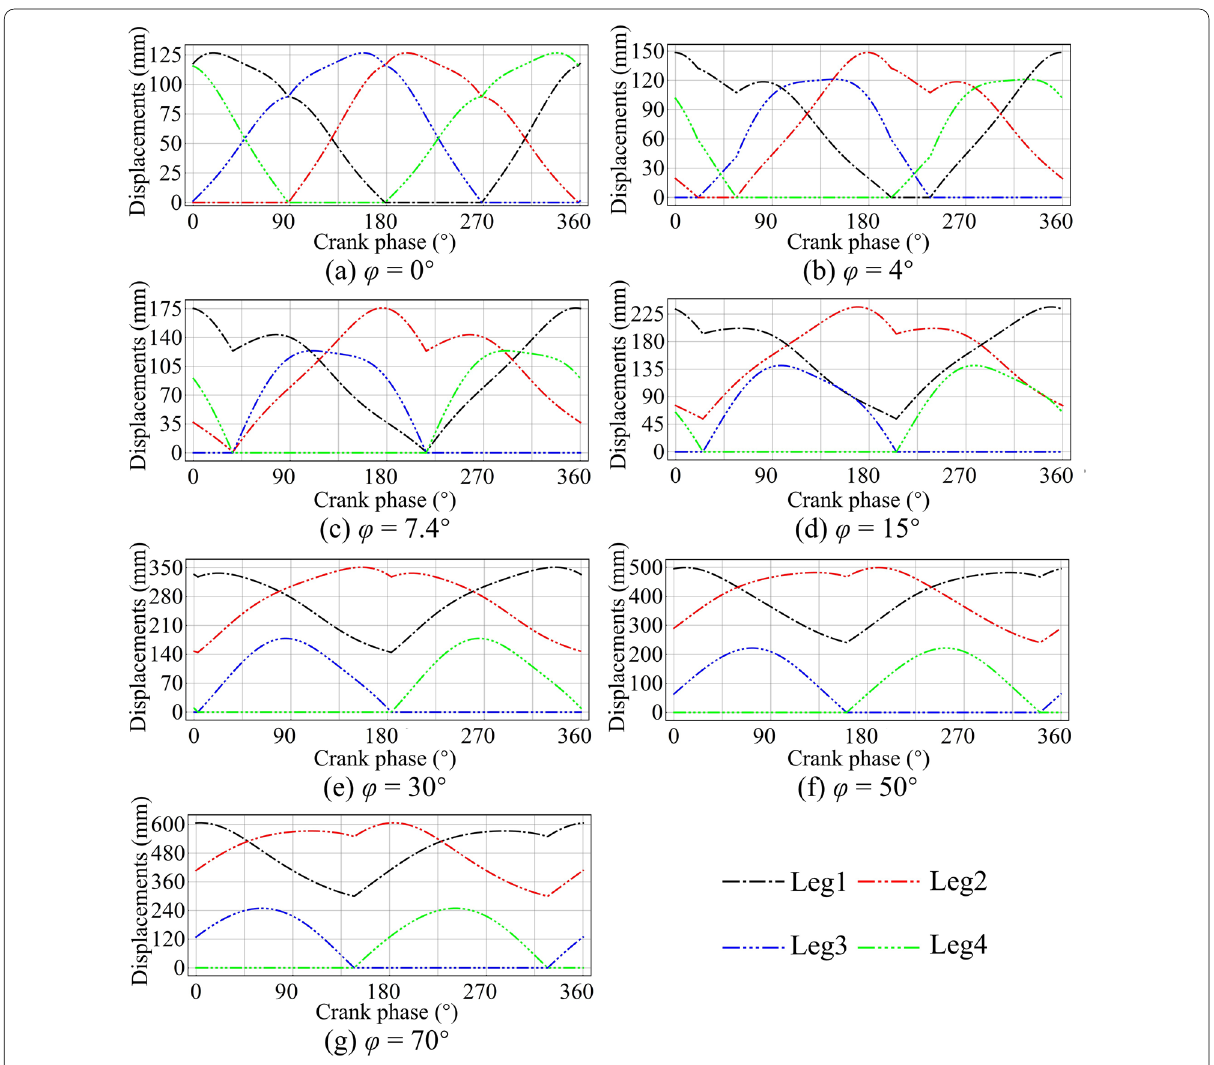
Figure 6 Foot end vertical displacements of Q‑LUAP